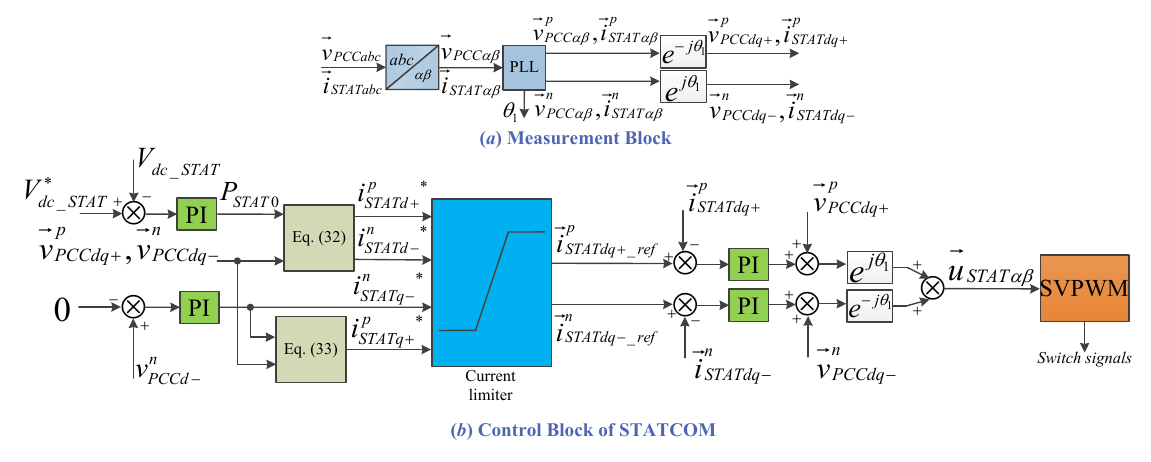
Figure 7. Voltage compensation control scheme of STATCOM.